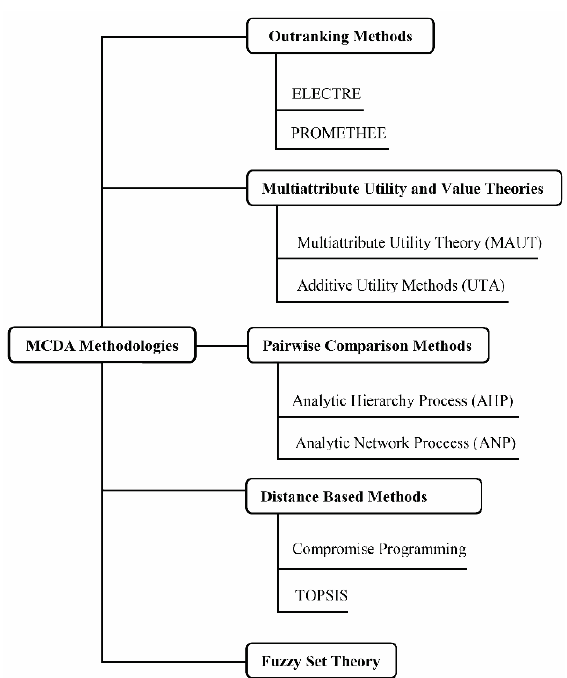
Figure 1. General multi-criteria decision analysis (MCDA) technique classification, adapted from Figueira et al. [35].